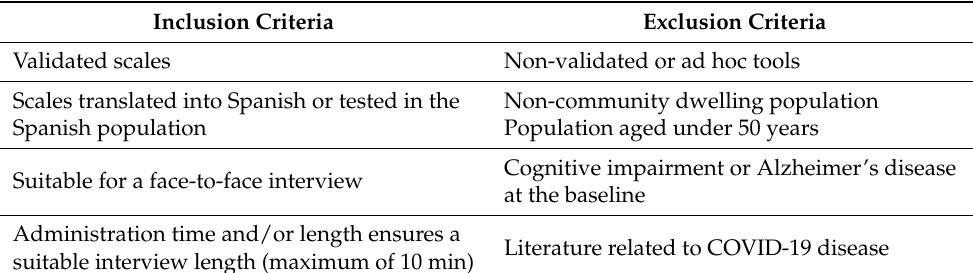
Table 1. Inclusion and exclusion criteria for meaning in life and psychosocial factors used for the bibliographic literature review. Inclusion Criteria Exclusion Criteria Validated scales Non-validated or ad hoc tools Scales translated into Spanish or tested in the Non-community dwelling population Spanish population Population aged under 50 years Cognitive impairment or Alzheimer’s disease Suitable for a face-to-face interview at the baseline Administration time and/or length ensures a Literature related to COVID-19 suitable interview length (maximum of 10 min)